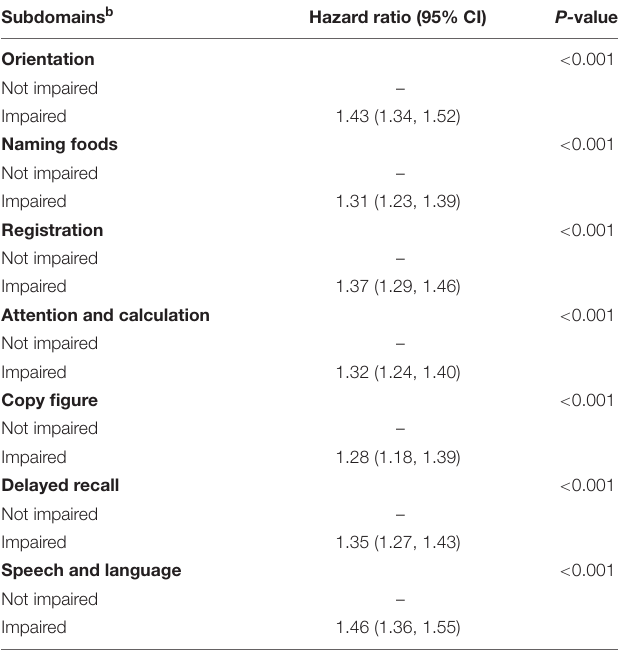
TABLE 3 | Association of hearing impairment with all-cause mortality by different cognitive function subdomains a . Subdomains b Hazard ratio (95% CI) P-